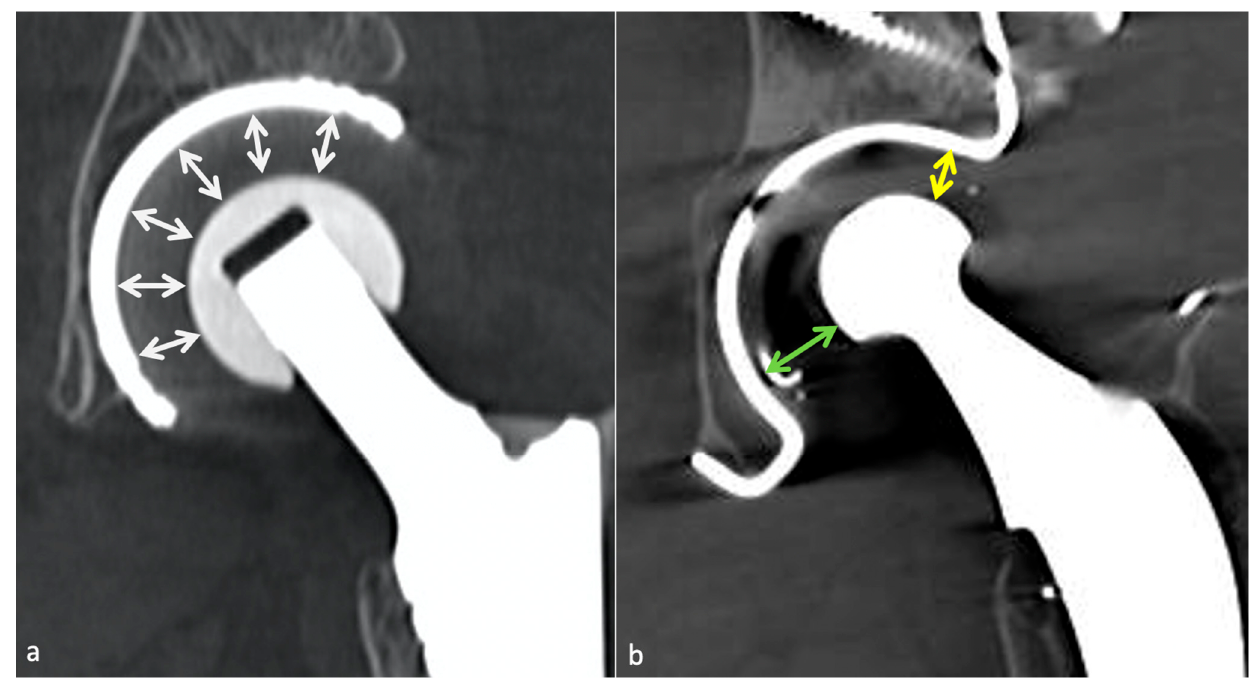
Figure 10. Polyethylene wear. Normal polyethylene appearance is shown in ( a ) a frontal CT ‐ scan slice, with a regular thickness as all double arrows are equal, whereas wear is shown in ( b ) a similar frontal CT ‐ scan slice, with asymmetric thickness as the superior yellow double arrow is smaller than the inferior green one.